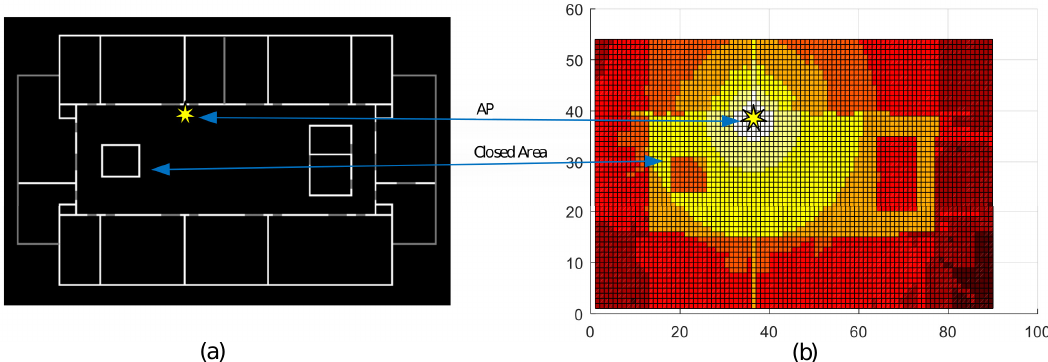
Figure 1. Site wall-map and the corresponding estimated radio-map, clearly showing the change in received signal strength indicator(RSSI) with respect to line-of-sight and non-line-of-sight cases; ( a ) site wall-map and ( b ) RSSI radio-map of an Access